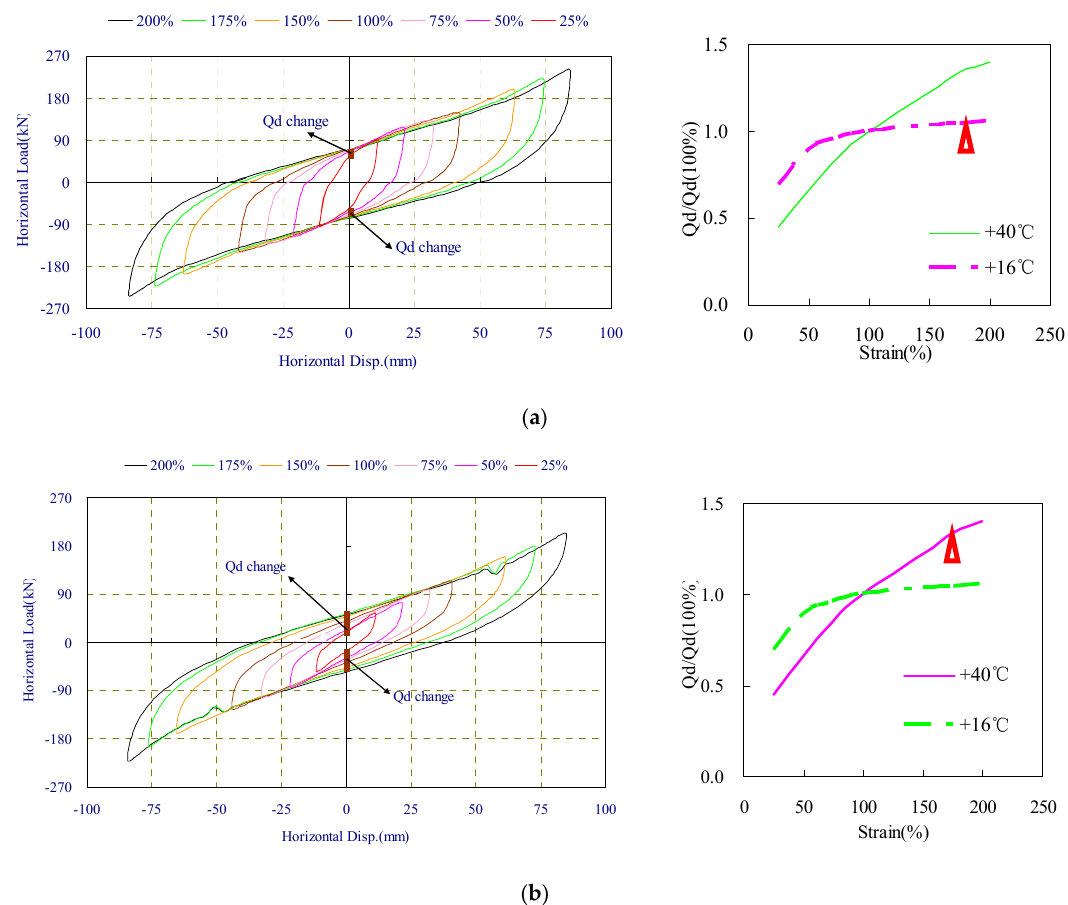
Figure 11. The different shear strain hysteresis loops of LRB at different temperature: ( a ) LRB at 16 ◦ C; ( b ) LRB at 40 ◦